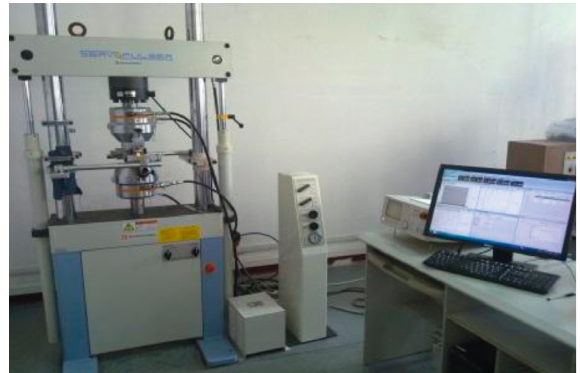
Figure 5: Shimadzu electrohydraulic servocontrol fatigue test machine.